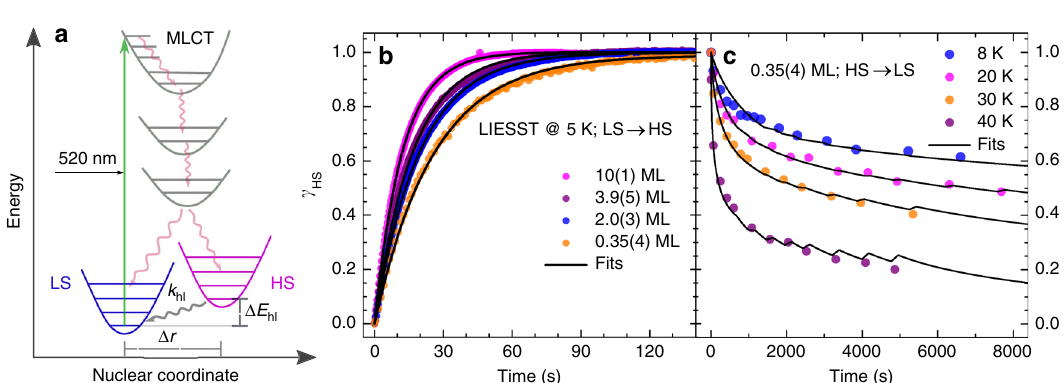
Fig. 3 Light-induced LS → HS state transition and the eventual HS → LS state decay at low temperatures. a Schematic representation of the light-induced LS → HS state transition — the excitation of electrons from the LS state to the MLCT (metal-to-ligand charge transfer) states, and subsequent relaxation to the HS state via intermediate states — and the eventual decay of HS to the LS state; b light-induced LS → HS state transition at 5 K for the different coverages, and c the HS → LS relaxation of 0.35(4) ML at 8, 20, 30, and 40 K (dots). The solid lines are the result of a simultaneous fi ts to Equation (2) together with the SOXIESST rates. The step-like features at the data points are due to the SOXIESST (soft-x-ray-induced excited spin-state trapping)